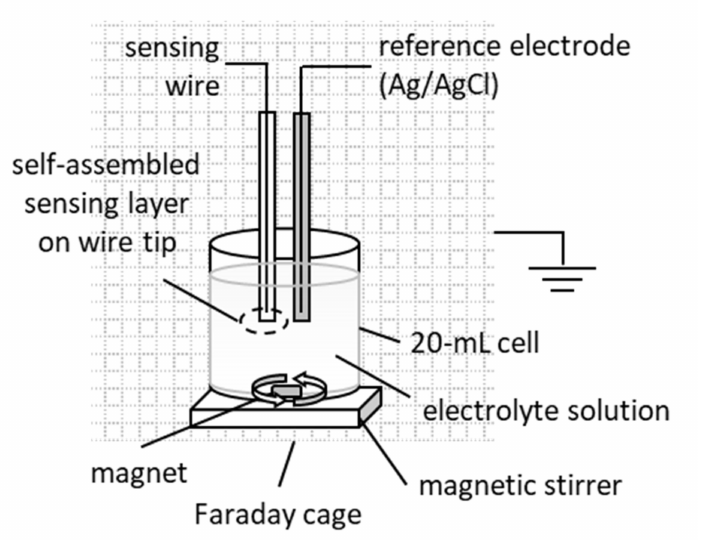
Figure 2. Overview of the electrochemical set-up for metal-supported biosensors. The applied potential at the sensing electrode is positive relative to ground. Not drawn to scale.